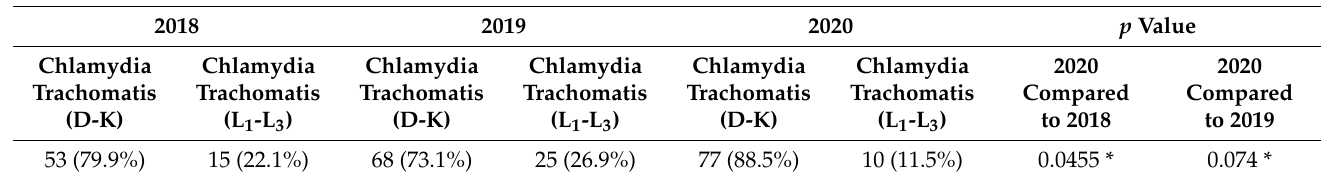
Table A4. The number and proportion (%) of patients diagnosed with chlamydia trachomatis D-K serotype and L 1 -L 3 serotype from 1 January to 30